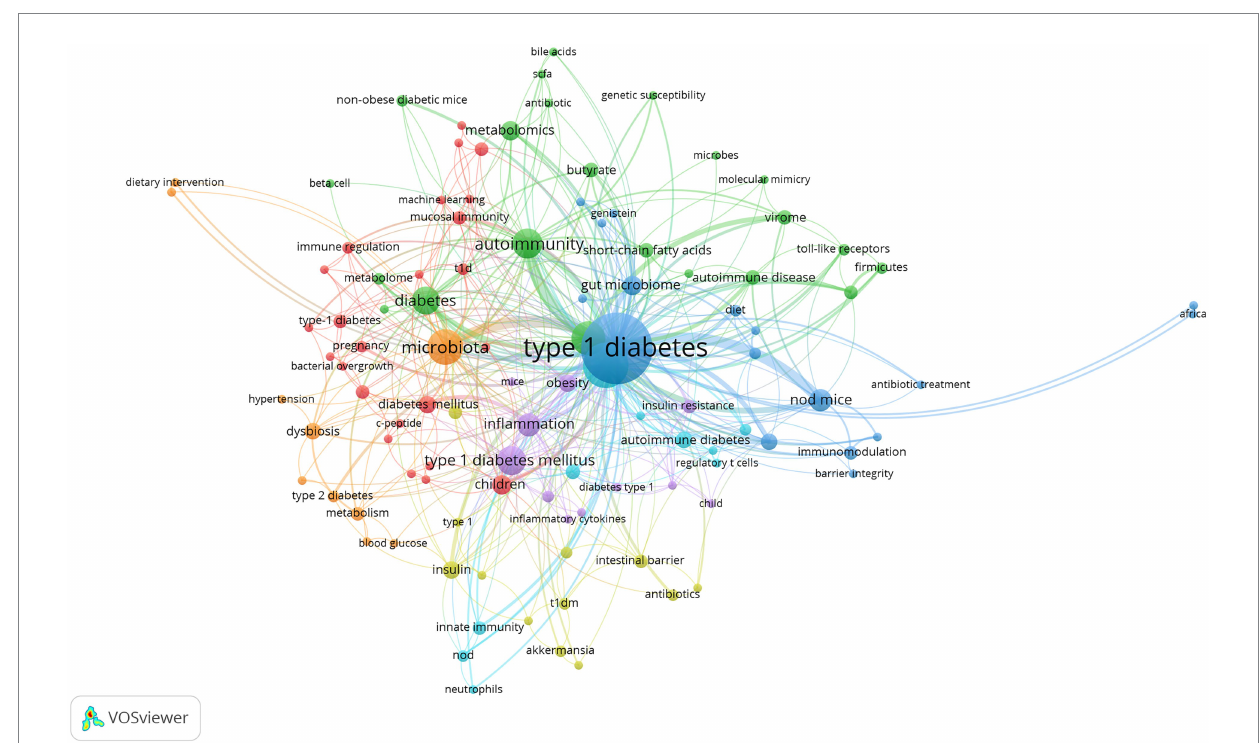
FIGURE 8 Cluster analysis of high-frequency keywords.